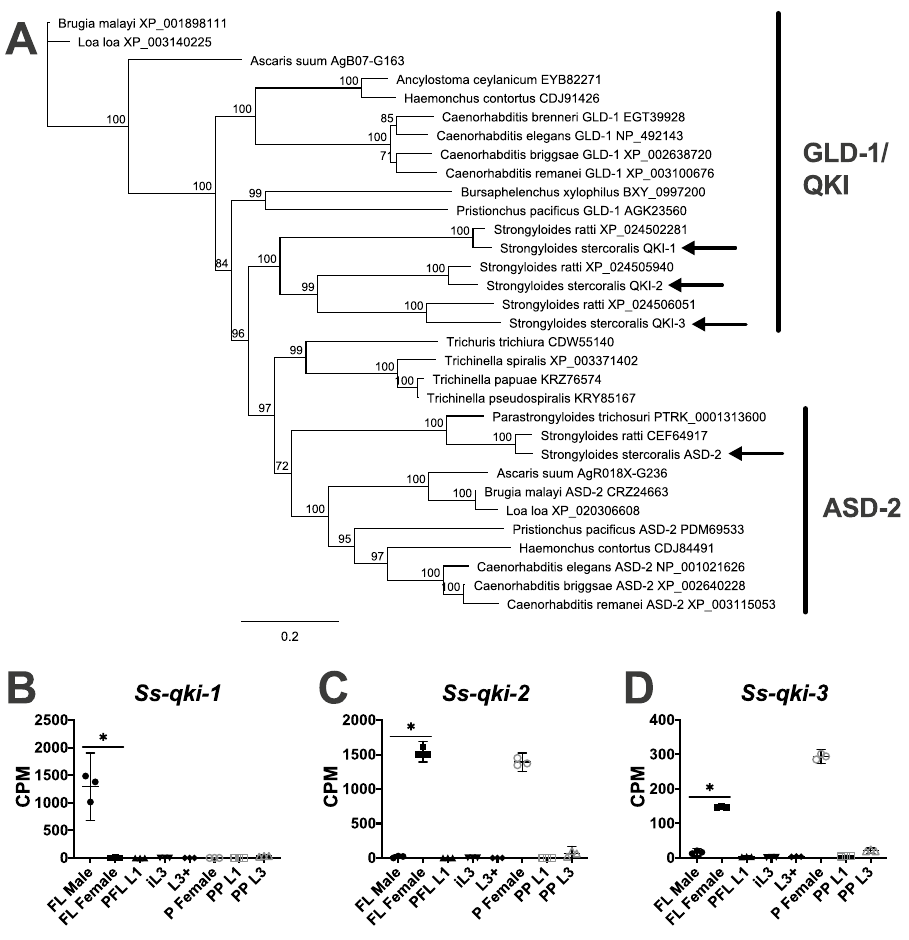
Figure 4. The S. stercoralis genome encodes three GLD-1 paralogs with transcripts that are sex specific. ( A ) Homologs of GLD-1 and ASD-2 in S. stercoralis (arrows) and other III, IV, and V nematodes are identified in a neighbor-joining phylogenetic tree with 100 iterations of bootstrapping constructed with Geneious v.11.1.5. Gene names and accession numbers are listed after the species names. ( B-D ) Transcript abundances of the three S. stercoralis paralogs are represented using TMM-normalized counts per million (CPM) for the following developmental stages: free-living adult males (FL Male), free-living gravid adult females (FL Female), post- free-living first-stage larvae (PFL L1), developmentally arrested infectious third-stage larvae (iL3), L3 activated inside a permissive host (L3 +), parasitic gravid adult females (P Female), heterogonically-developing post- parasitic L1 (PP L1), and heterogonically-developing post-parasitic L3 enriched for females (PP L3). Graphs were constructed using GraphPad Prism v.9.0.0; bars indicate means (horizontal) and 95% confidence intervals (vertical) for each of the three biological replicates represented as individual data points. Asterisks (*) indicate a significant (fold change > 2.0; FDR < 0.05) difference between FL Male and FL